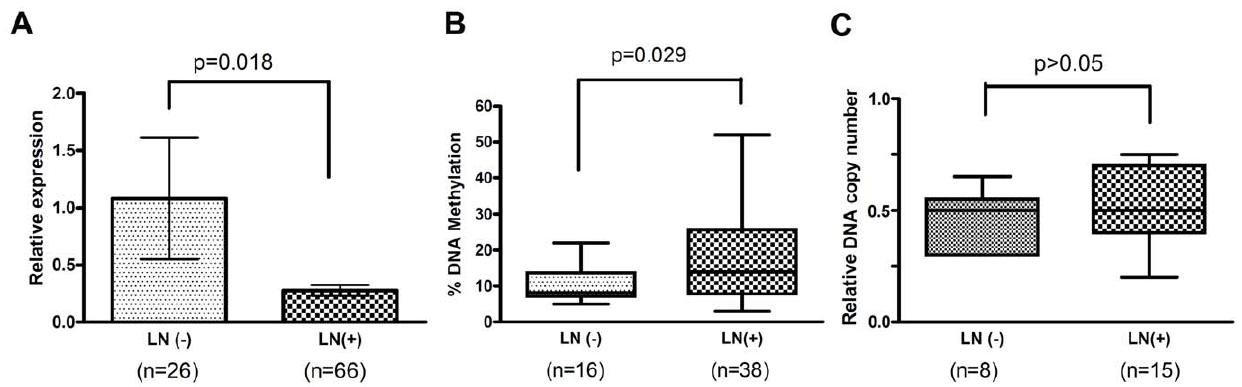
Figure 6. Dysfunction of GPX3 correlated with lymph node metastasis. (A) Loss of GPX3 gene expression correlated with lymph node metastasis. (B) Increase in GPX3 methylation correlated with lymph node metastasis. (C) GPX3 copy number change did not correlate with lymph node metastasis.